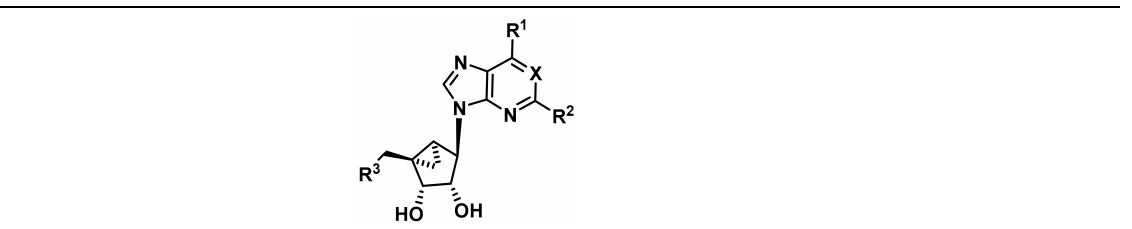
Table 1. Inhibitory activities of the novel compounds in human adenosine receptor binding assays ( n = 3), a % displacement by the test compound at a concentration of 10 µ M, or at 1 µ M. Bn = benzyl, PMB = p